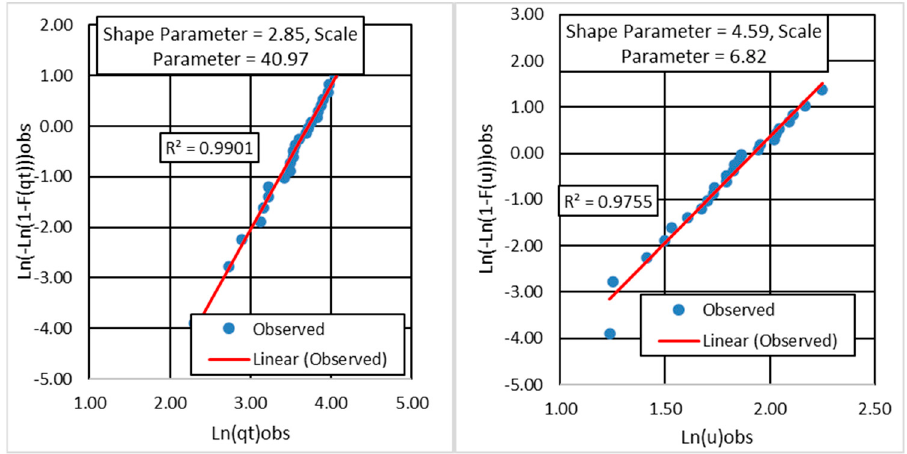
Figure 8. Weibull descriptors of queuing time ( left ) and wind speed ( right ).